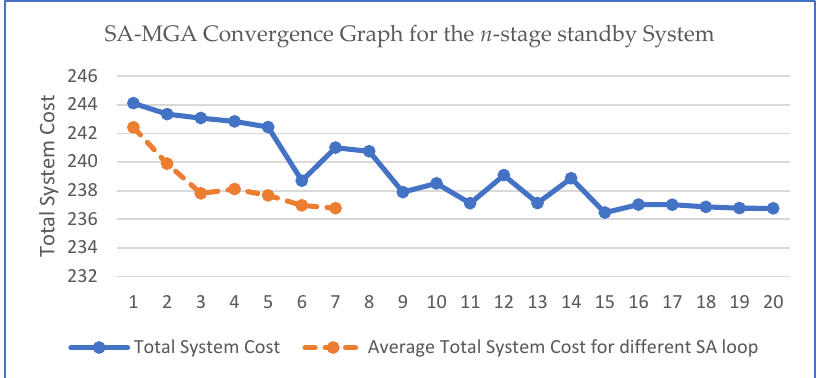
Figure 5. The convergence graph of n -stage standby system by conducting SA-MGA combined method.